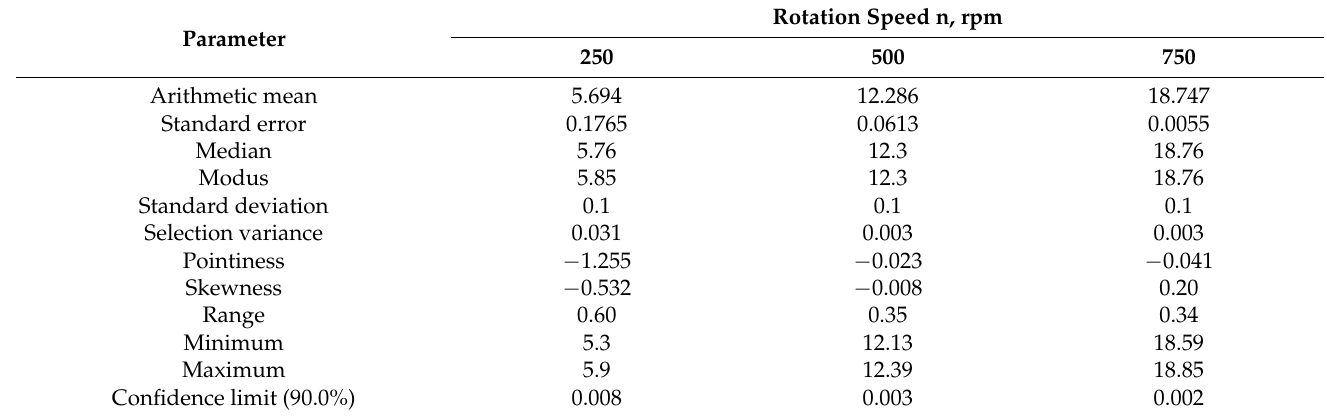
Table 13. Results of descriptive statistics from the set of flow values at the specified values of rotation of